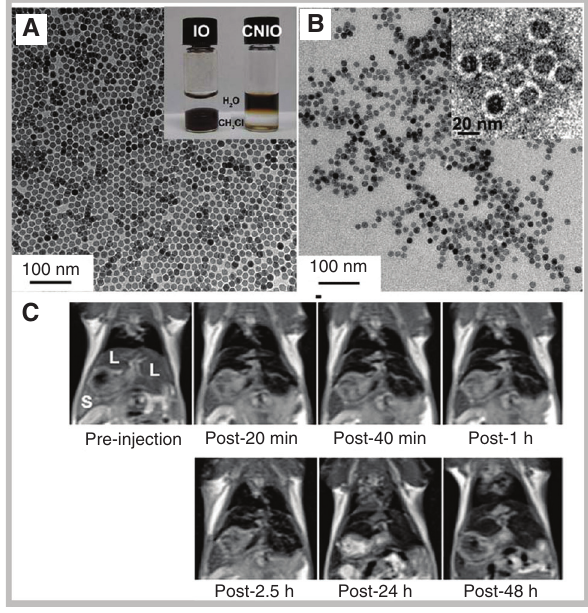
Figure 1 Casein-coated iron oxide nanoparticles (CNIO) for MRI contrast enhancement and efficient cell targeting. The transmission electron microscopy (TEM) images of (A) hydrophobic iron oxide (IO) nanoparticles before modification and (B) after being coated with casein (CNIOs). Inset of (A) is a photograph of hydrophobic IO nanoparticles dispersed in chloroform (left) and water-soluble CNIOs (right); inset of (B) is a negative-stained TEM image that shows a protein coating (bright layer surrounding the particles); (C) T2-weighted MR images of a mouse before and after injection of CNIOs at a dosage of 2.5 mg Fe/kg per mouse body weight. (Repro- duced with permission from Ref. [40], Copyright ACS Publications,